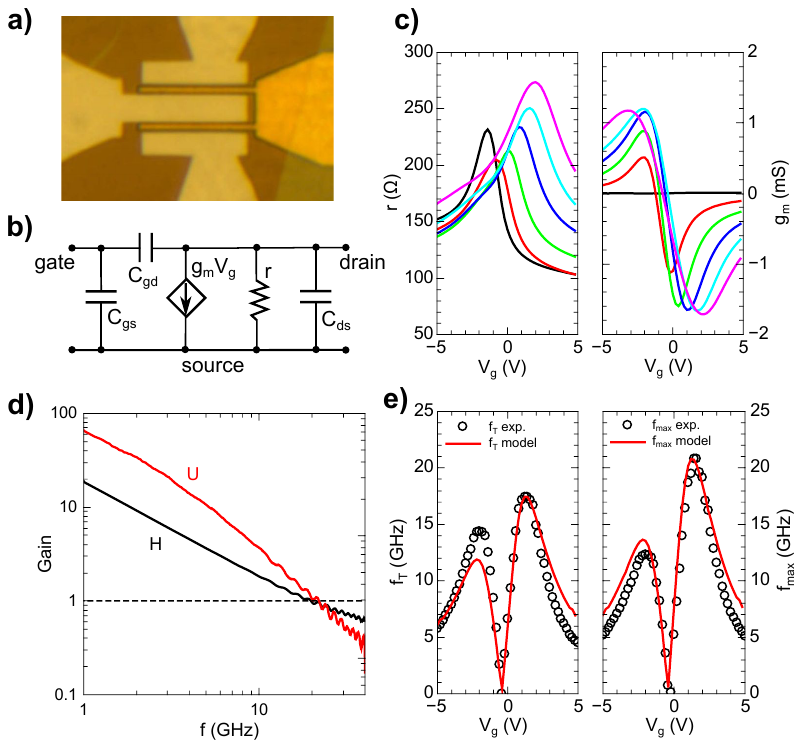
Figure 2. Radio-frequency GFETs. ( a ) Optical image of sample-B before graphene and contact deposition. Dimensions: L = 800 nm, W = 22 µ m and t BN = 18 nm. ( b ) Small signal lumped elements circuit of an RF transistor. ( c ) RF small signal resistance r and transconductance g m of sample-B measured at 2 GHz for biases in the 0–2 V range. ( d ) Logarithmic plot of the current H(f) and Mason U(f) gains measured between 1 GHz and 40 GHz after de-embedding. ( e ) V g dependence of the corresponding measured cut-off frequencies (black circles) together with the model prediction (red